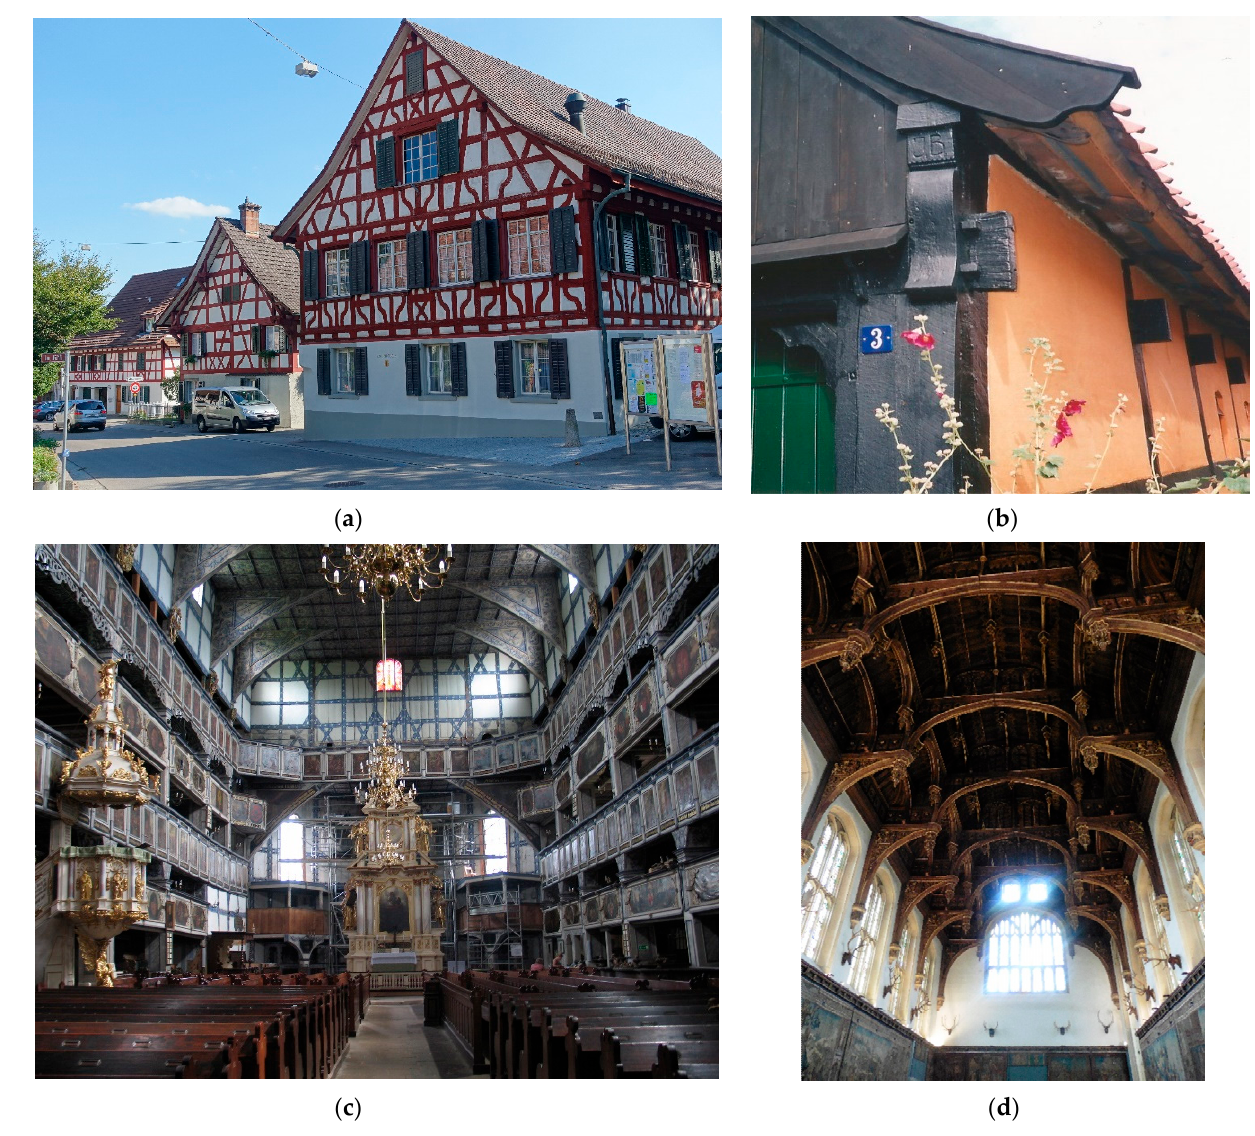
Figure 2. ( a ) Half-timbered buildings in the Swiss village Marthalen; photo: Joanna Arlet; ( b ) Svaneke (Bornholm) building with characteristic mortise and extended tenon joints; photo: Joanna Arlet; ( c ) rich ornaments inside the Church of Peace in Jawor; photo: Joanna Arlet; ( d ) Hampton Court Palace, Great Hall; photo: Joanna Arlet .